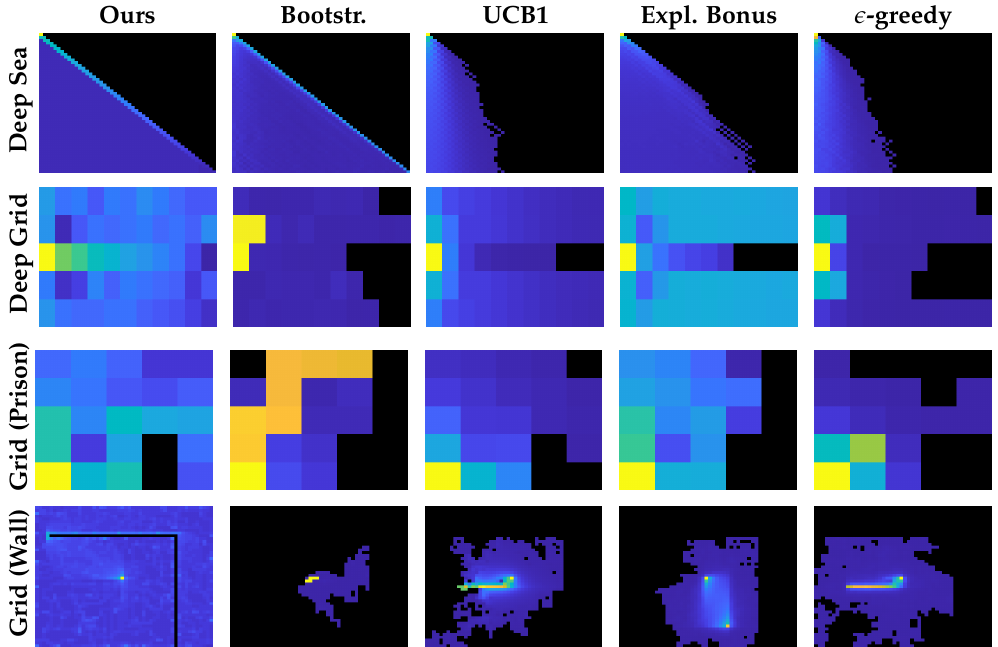
Figure 19. Visitation count at the end of the learning. The seed is the same across all images. Initial states naturally have a higher count than other states. Recall that the upper portion of the deep sea and some gridworlds cells cannot be visited. Only the proposed methods explore the environment uniformly (figures show the count of UCB-based W-function. Count-based W-function performed very similarly). Other algorithms myopically focus on